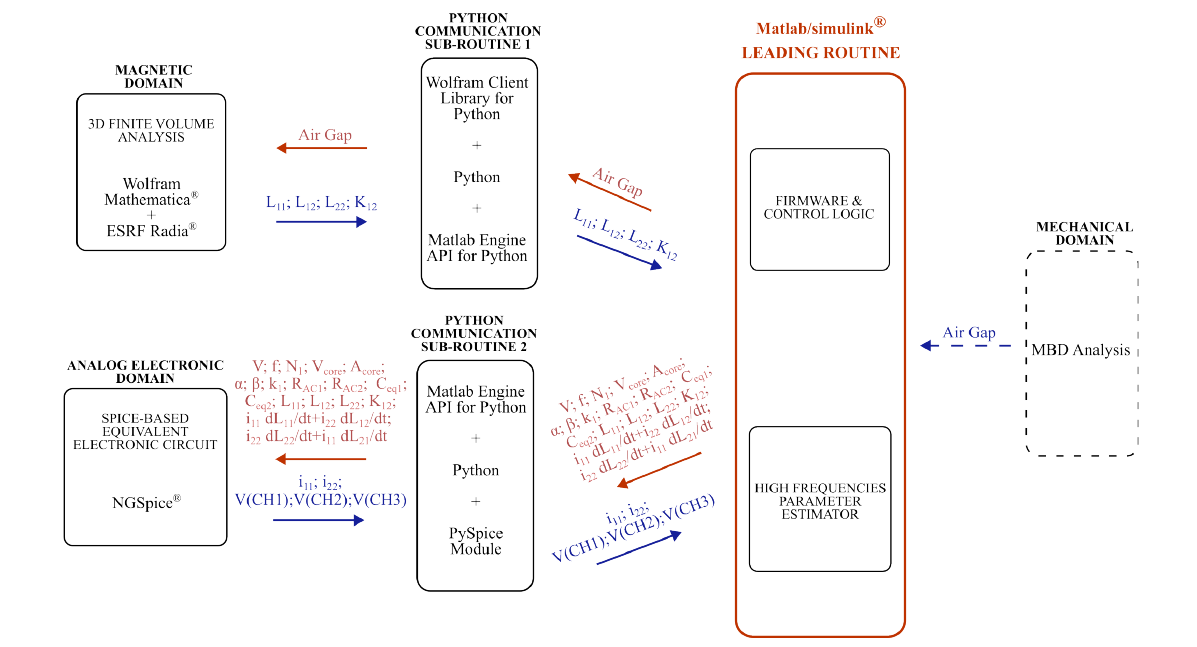
Figure 2. Complete multi-domain architecture for the co-simulation of the WPT device.